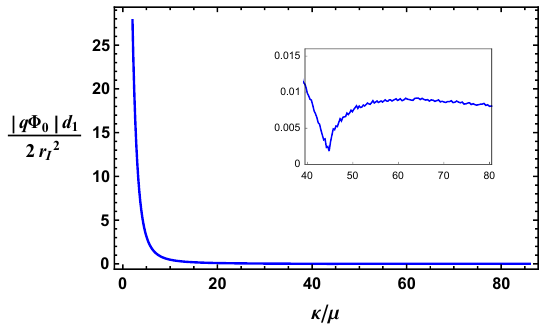
Figure 18 . The behavior of the relation (6.2) with respect to κ/µ